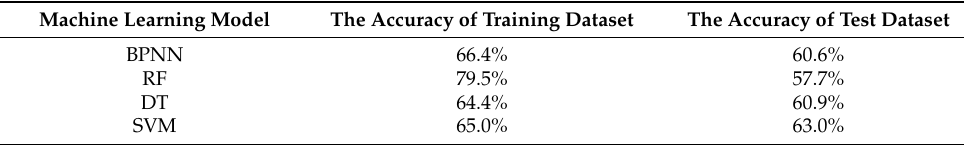
Table 2. Accuracy data for the training and test sets for four models.